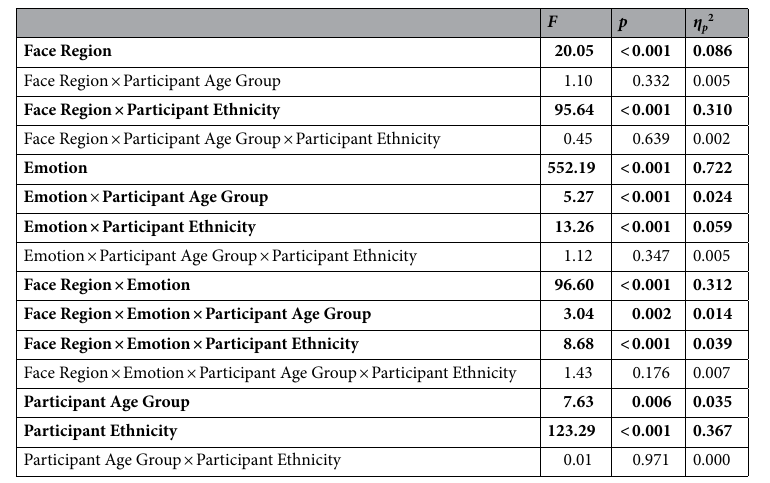
Table 1. Summary of emotion recognition effects from the analysis of variance. Significant effects are in bold